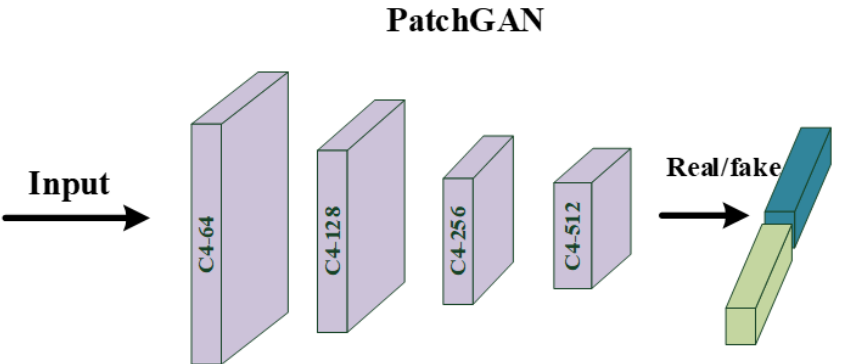
Figure 5. The detailed structure of the classical PatchGAN.